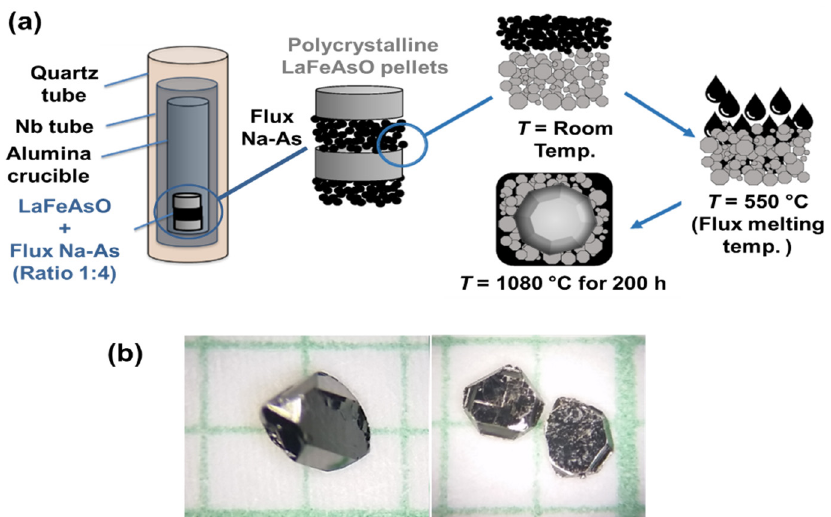
Figure 5. ( a ) A block diagram of the Solid-State Crystal Growth (SSCG) process at ambient pressure (SSCG-AP). The Na-As, as the liquid medium promotor for the growth, is used in between the pol- ycrystalline LaFeAsO pellets. After annealing, a bimodal size distribution has developed, including large, faceted crystals. ( b ) The grown LaFeAsO single crystals with pronounced facets have a thick- ness of ~0.4 mm